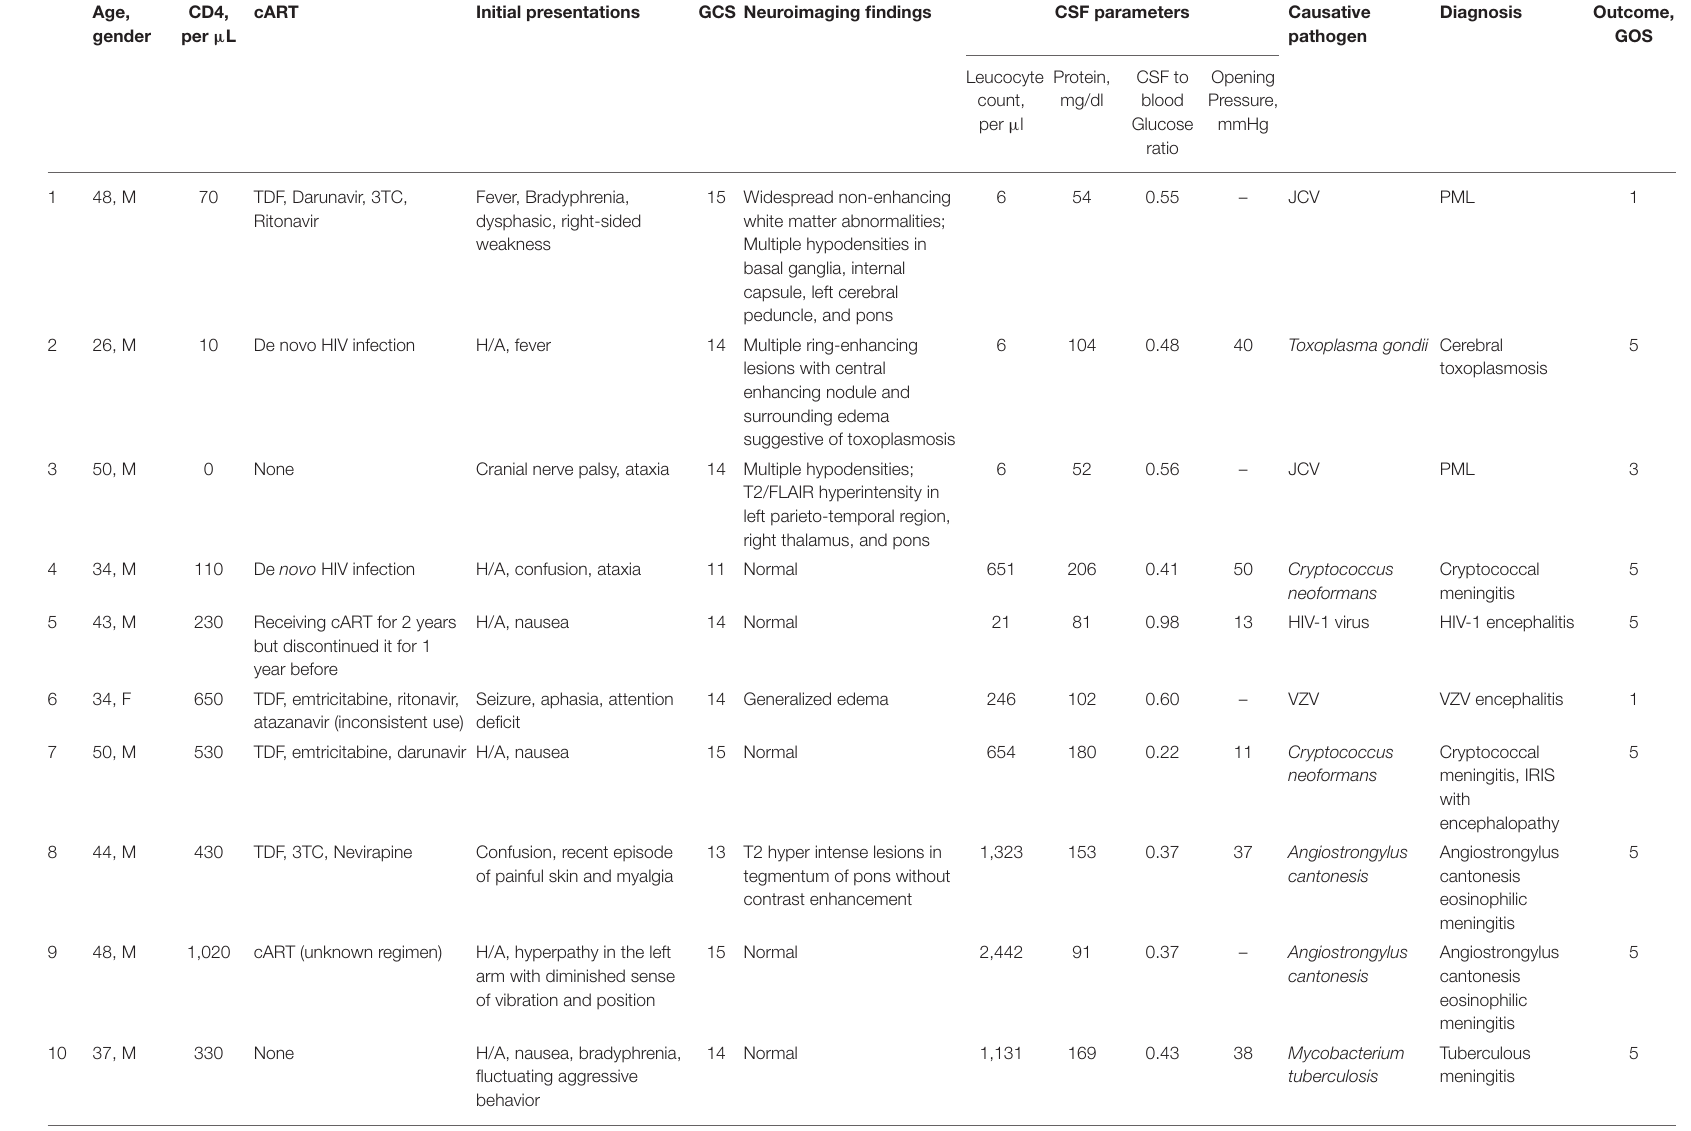
TABLE 3 | HIV-infected cases with CNS infections. Age,